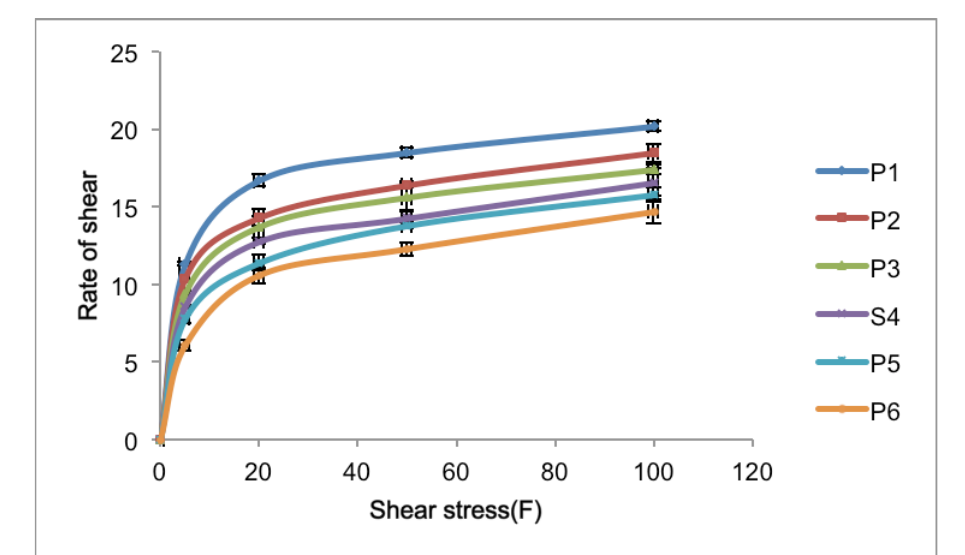
FIGURE 7 - Rheogram of pluronic lecithin organogel.